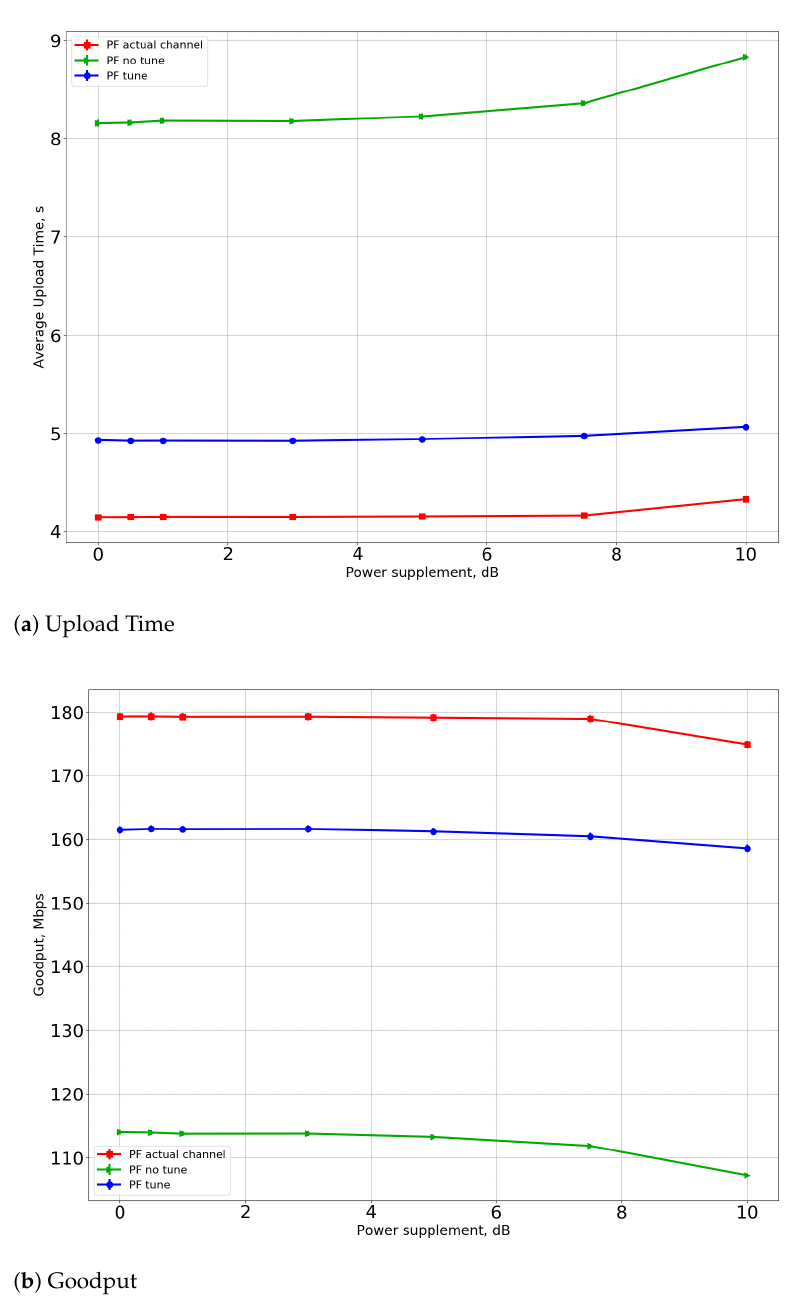
Figure 8. ( a ) Upload time and ( b ) goodput for power supplement for R =